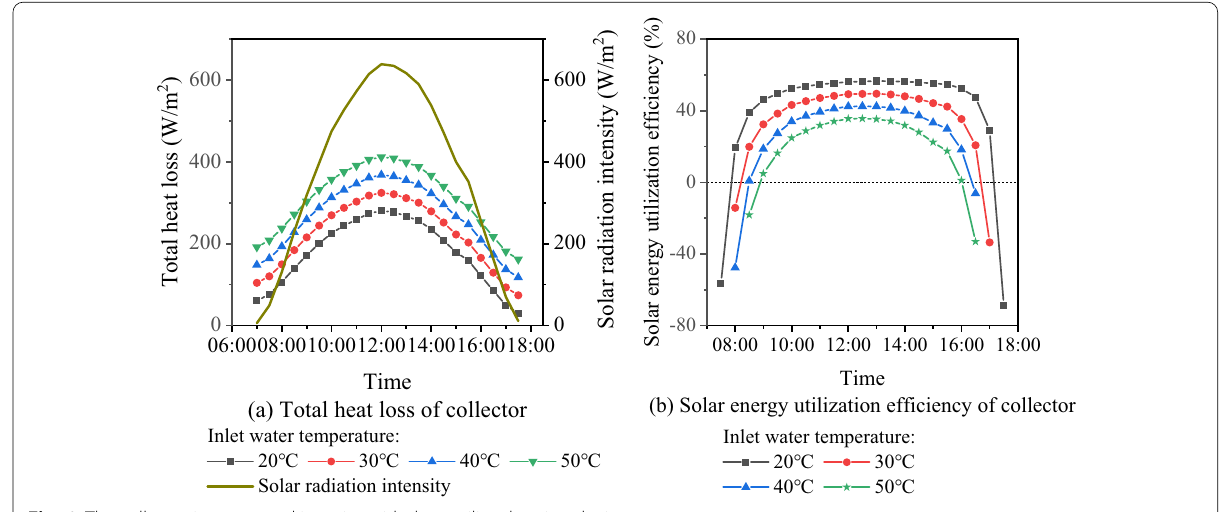
Fig. 6 The collector is connected in series with the auxiliary heating